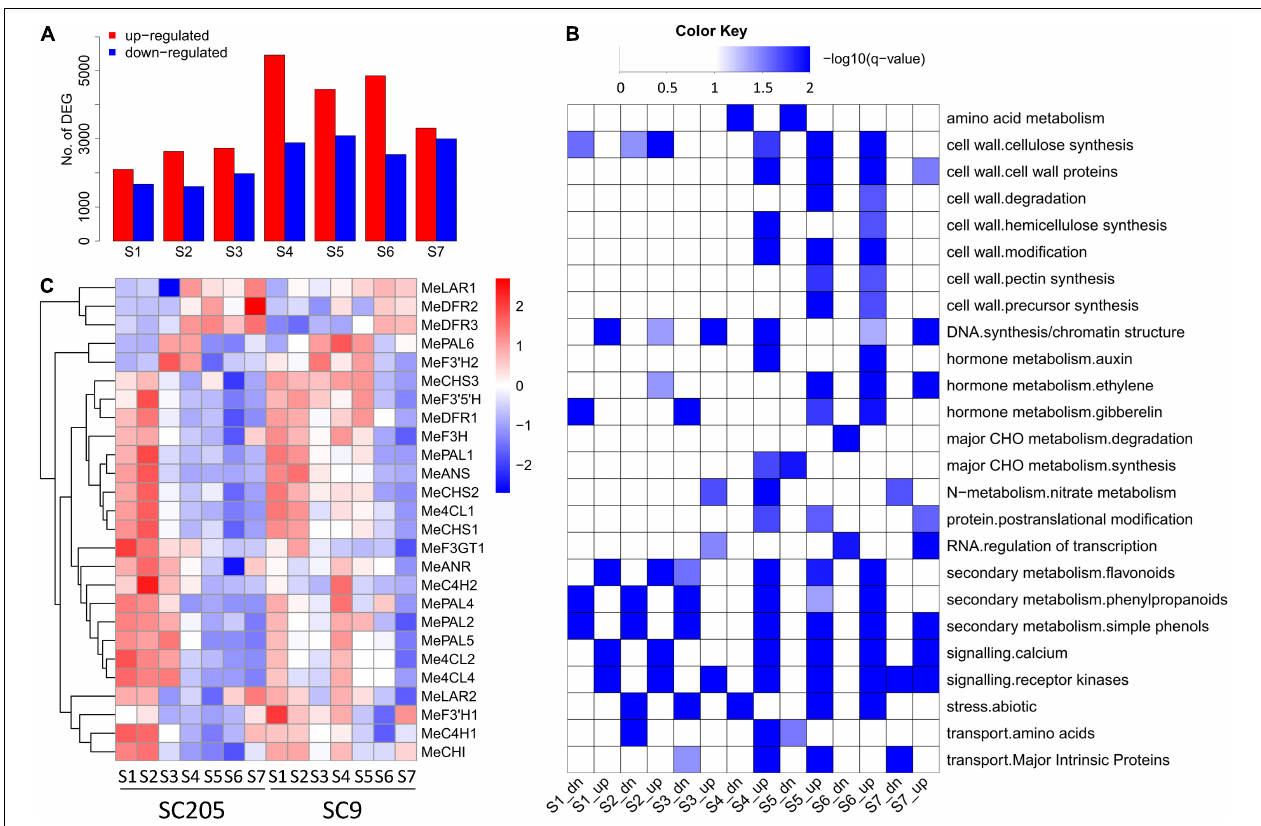
FIGURE 4 | Differentially expressed genes between SC9 and SC205 during tuberous root development. (A) Number of up-regulated and down-regulated DEGs, which showed higher and lower expression levels in SC9 than SC205, respectively. (B) Functional category enrichment of the up-regulated (suffixed with “up”) and down-regulated (suffixed with “dn”) DEGs presented in panel (A) . (C) Expression profiles of anthocyanin biosynthesis genes during tuberous root